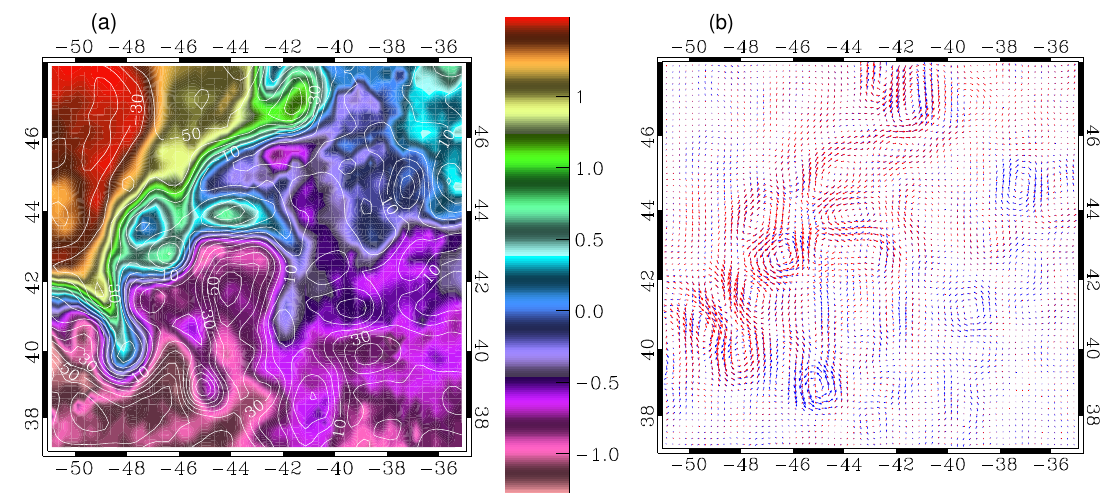
Figure 4. Validation of the SQG balance in the Gulf Stream region. ( a ) Sea surface temperature (shadings) and sea surface height (white contours); ( b ) corresponding velocity field, deduced from altimetry (blue arrows) and from SQG balance (red arrows). Note the good agreement between the two velocity fields. From [99], with permission of John Wiley and